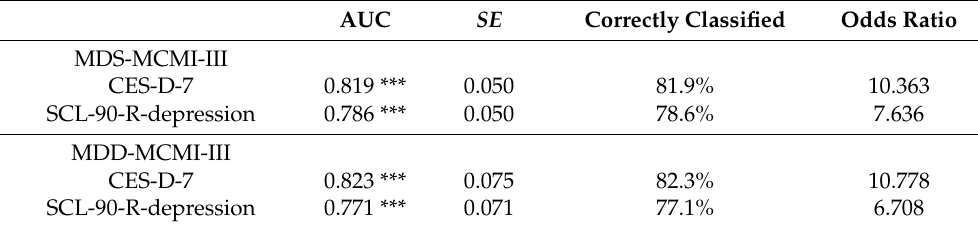
Table 1. The area under the curve of CES-D-7 and SCL-90-R’s depression subscale. AUC SE Correctly Classified Odds Ratio MDS-MCMI-III CES-D-7 0.819